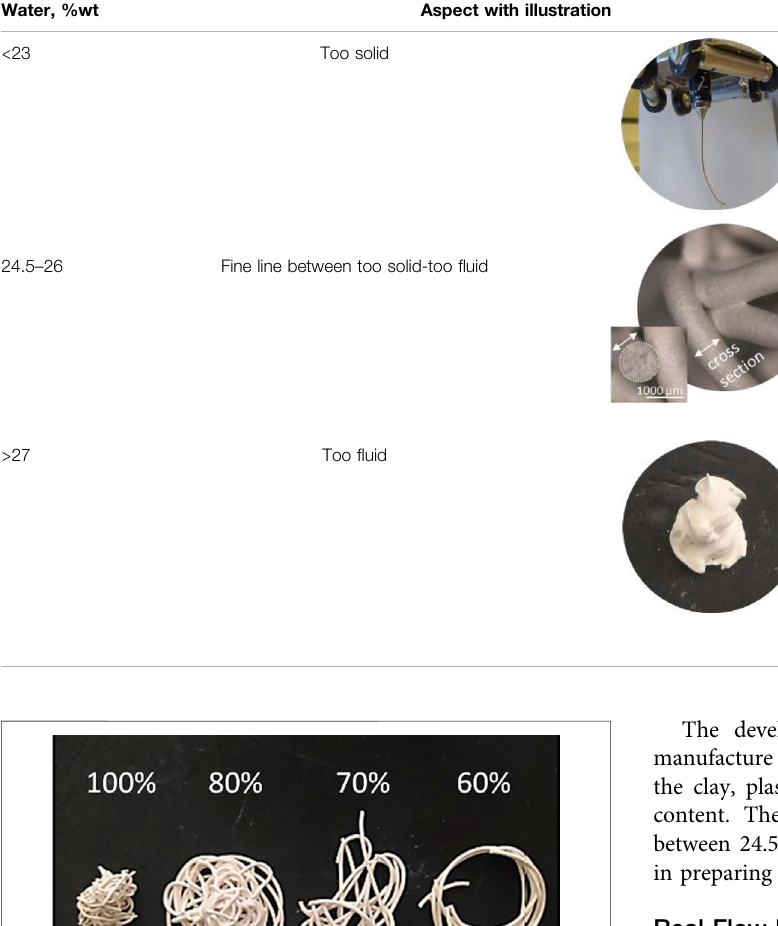
TABLE 2 | Percentage of water in printing paste, constant fl ow of 1 mm/s, nozzle diameter of 1.0 mm. Water, %wt